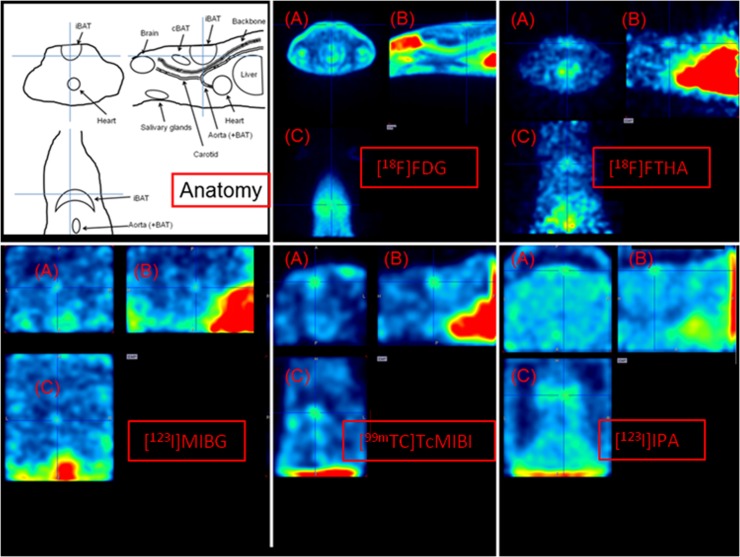
Transverse (A), sagittal (B) and coronal (C) slices of images from a room-temperature housed rat, centered on iBAT, depicting the anatomy, [18F]FDG distribution, [18F]FTHA distribution, [123I]MIBG distribution, [99mTc]TcMIBI and [123I]IPA distribution. Uptake in BAT is low for all tracers.